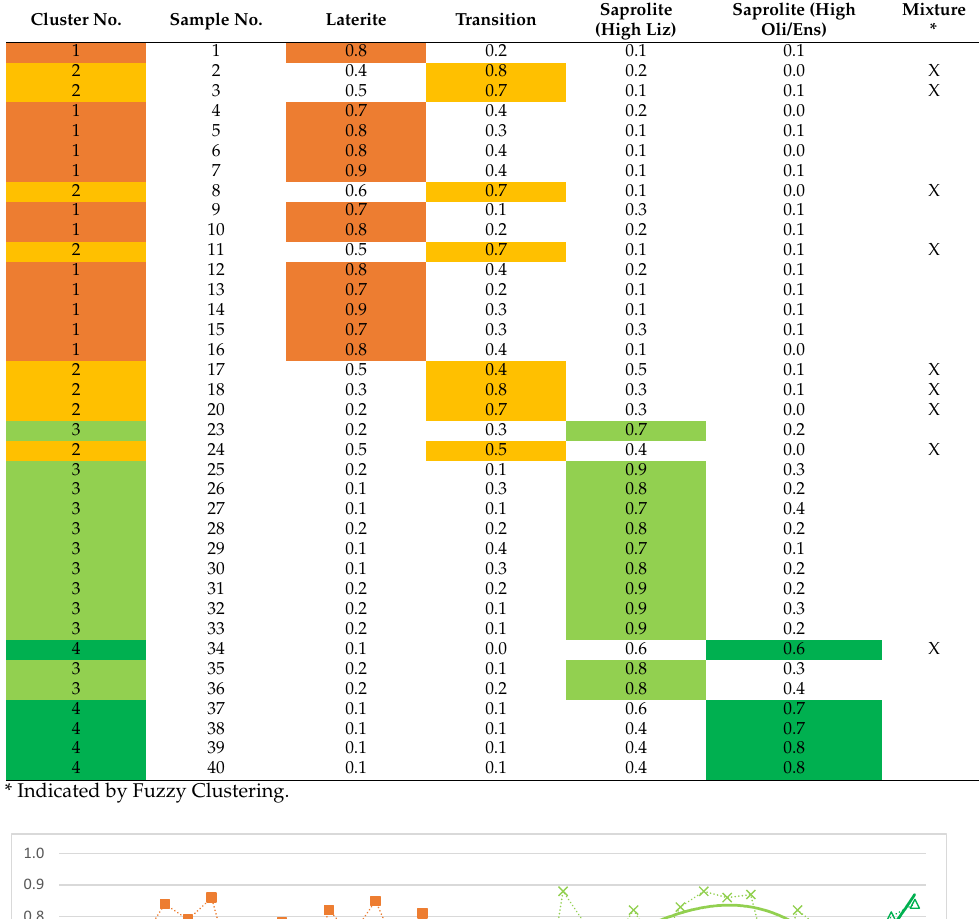
Table 1. Results of fuzzy clustering of 40 nickel laterite samples, refined membership coefficients, colors represent the different cluster as identified in Figures 5 and 6, Liz = Lizardite, Oli = Olivine, Ens = Enstatite.